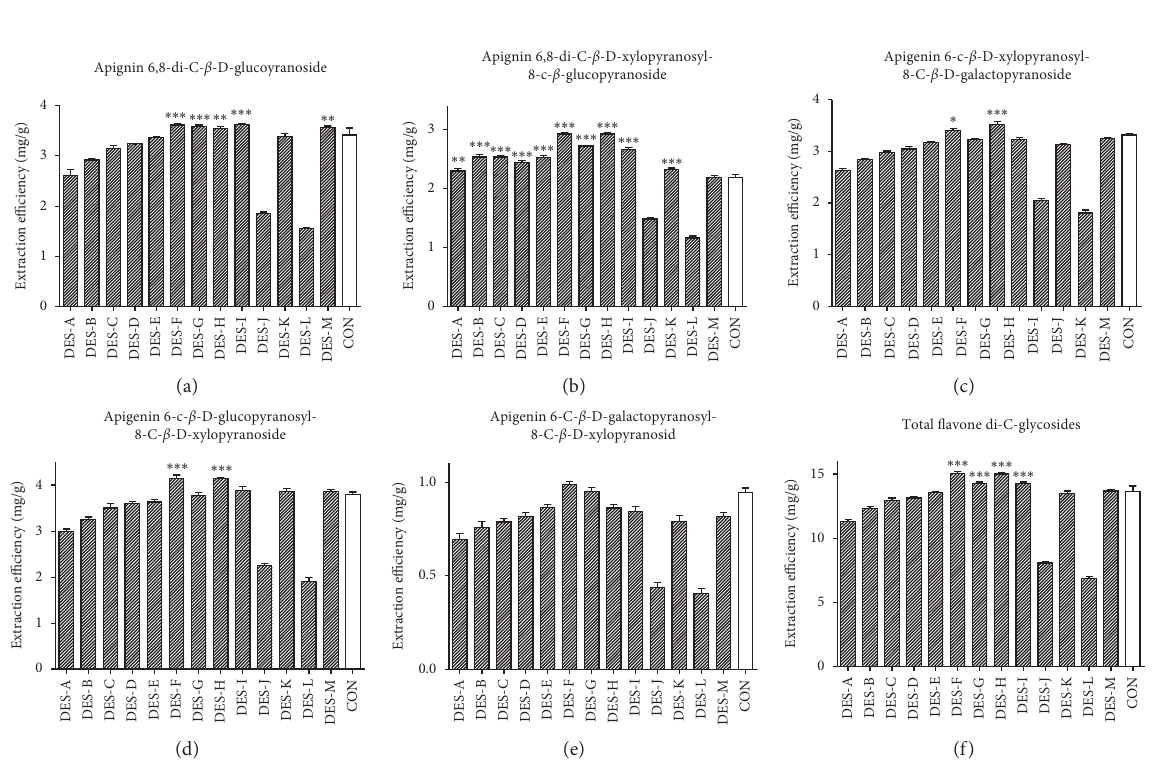
Figure 3: Extraction efficiency of the different DESs for flavone di-C-glycosides from Premna fulva Craib. The labels on the horizontal axis correspond to those given in Table 1. Error bars indicate the standard deviation ( n � 3). The extraction efficiency of different DESs compared with CON is indicated with ∗ p < 0 . 05, ∗∗ p < 0 . 01, and ∗∗∗ p < 0 . 001. CON: 40% ethanol. (a) Apigenin 6,8-di-C- β -D-glucopyranoside. (b) genin 6-C- β -D-glucopyranosyl-8-C- β -D-xylopyranoside. (e) Apigenin 6- C - β -D-galactopyranosyl-8- C - β -D-xylopyranoside. (f) Total fla- vone